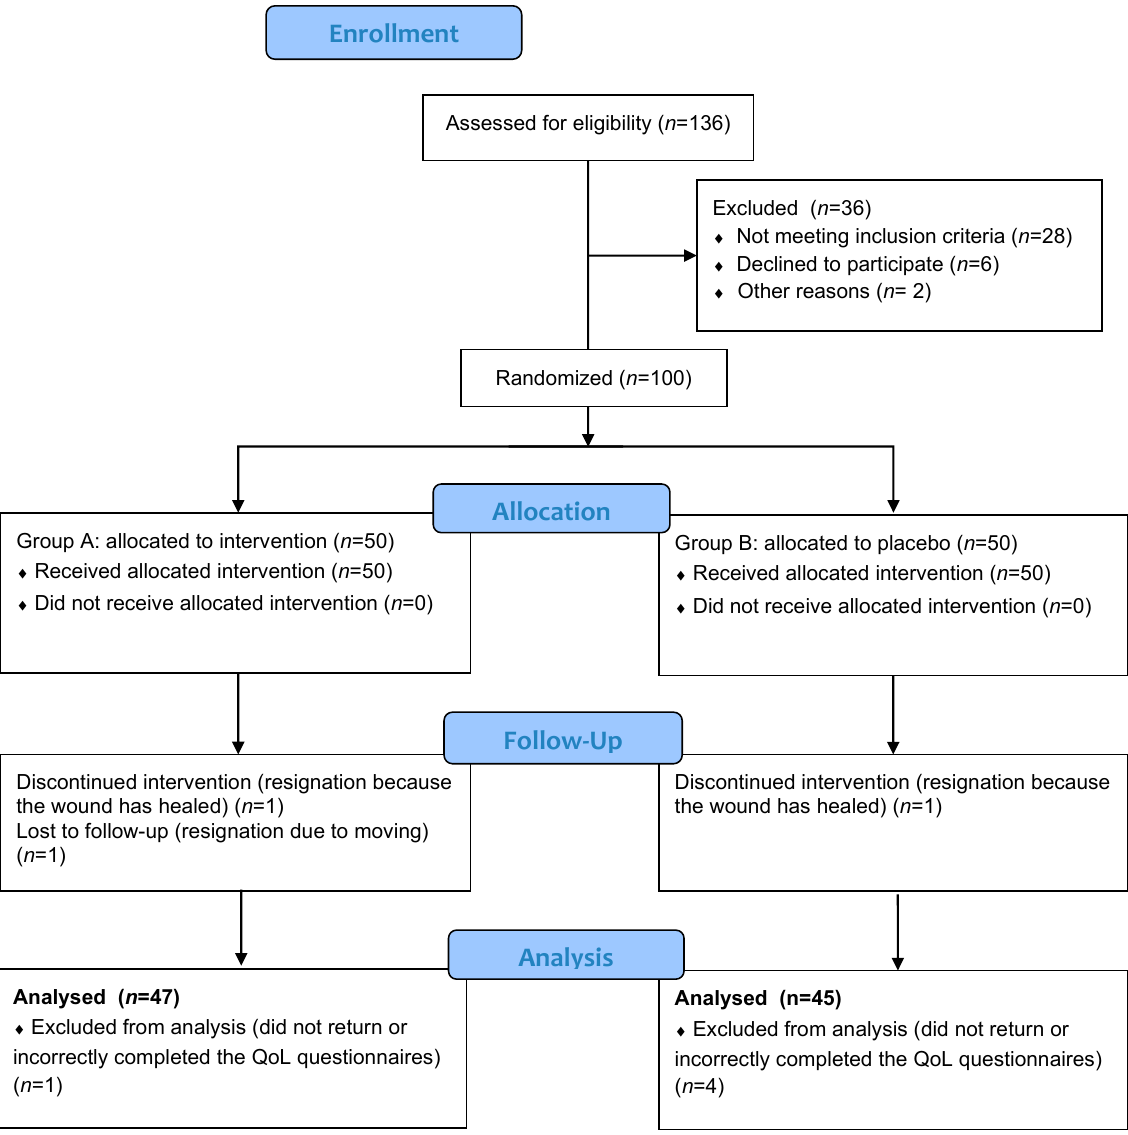
Figure 1. Flow diagram of the progress through the phases of a parallel randomized trial: A = tro- pocollagen group, B = placebo group .